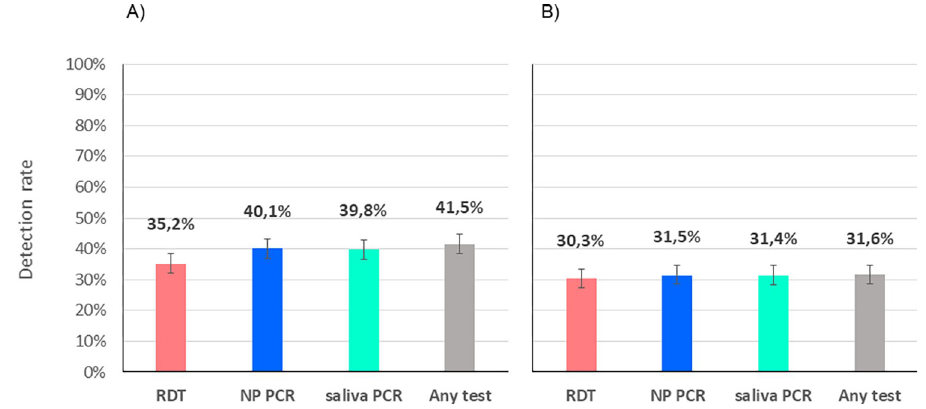
Fig 2. Detection rates of COVID patients by RDT, nasopharyngeal PCR and saliva PCR. A) all positive patients; B) positive patients with viral loads � 10 6 copies/ml by any PCR (supposedly significantly contagious).